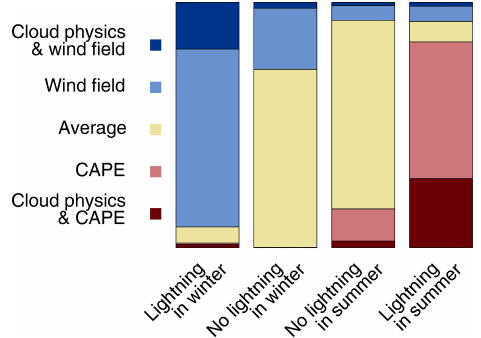
Figure 3. Stacked bar plot of the clusters (colors, y axis) found in the different scenarios (bars, x